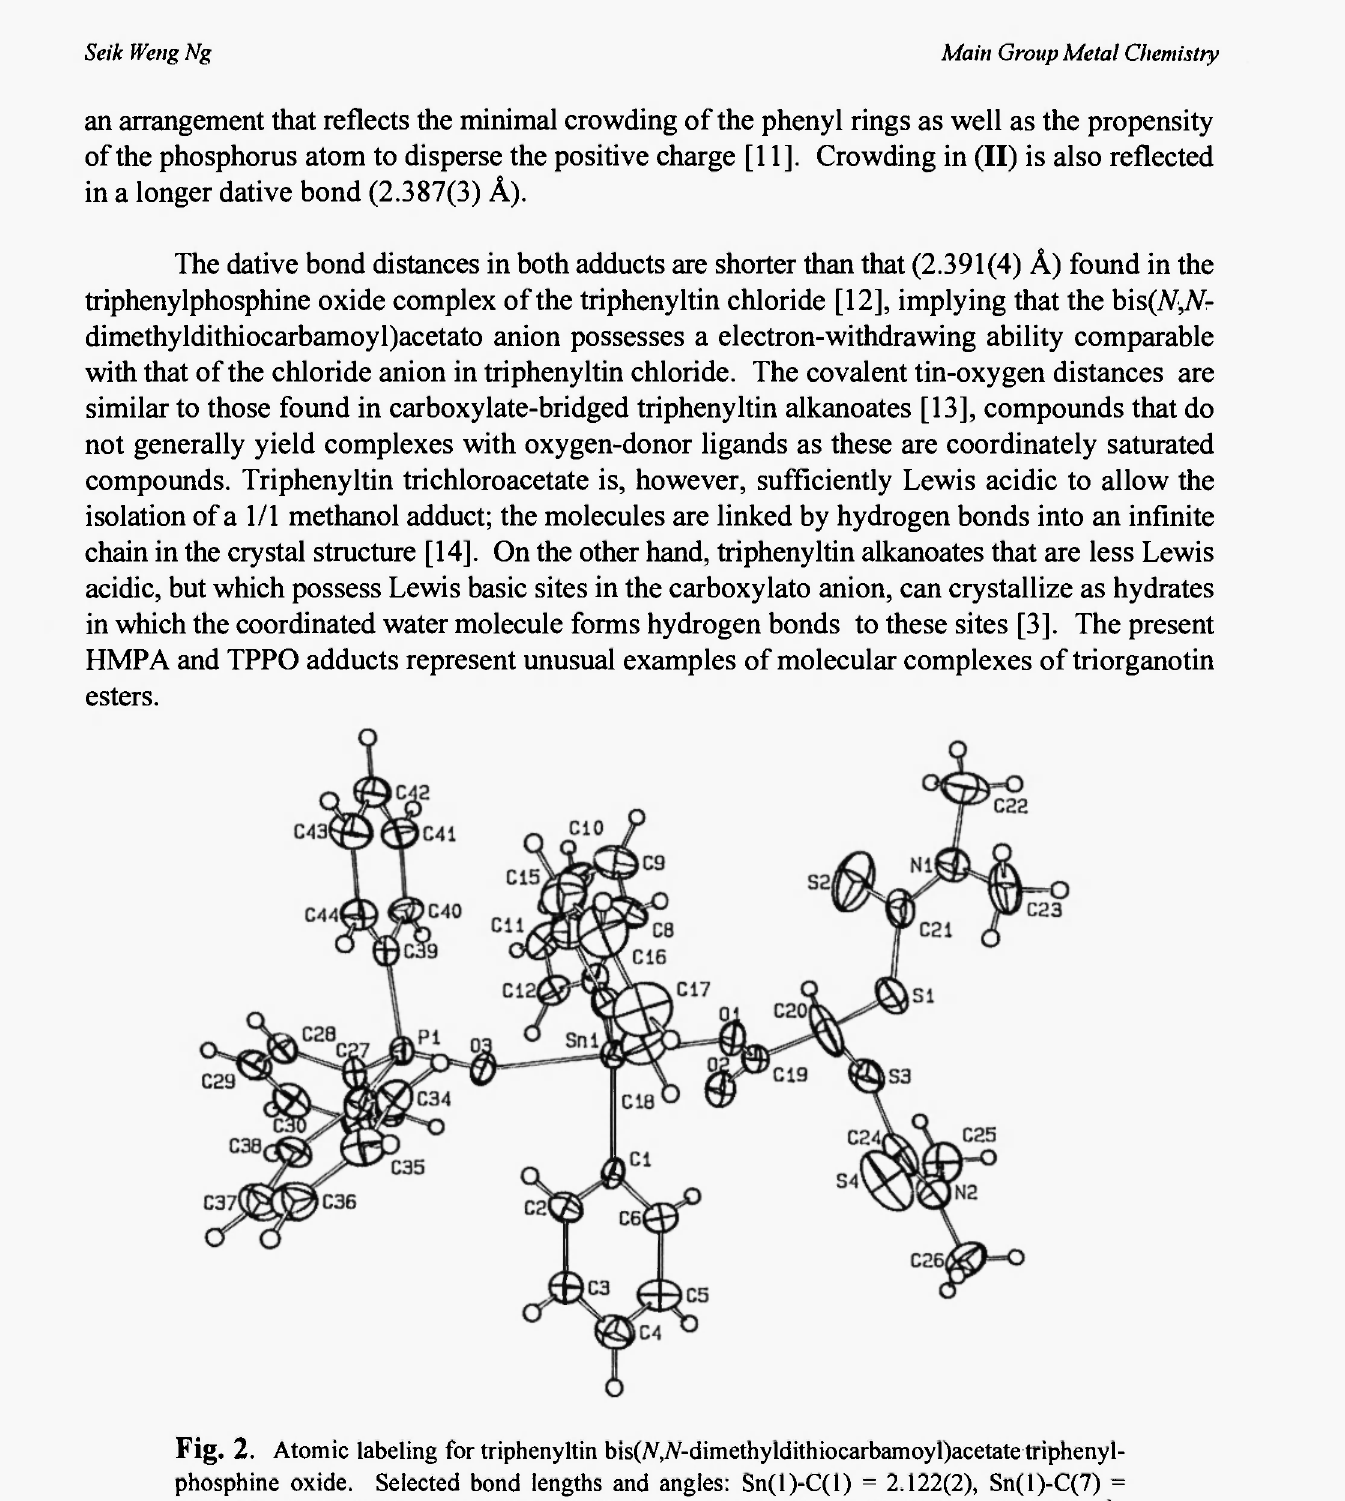
Fig. 2. Atomic labeling for triphenyltin bis(A r ,A r -dimethyldithiocarbamoyl)acetate triphenyl- phosphine oxide. Selected bond lengths and angles: Sn(l)-C(l) = 2.122(2), Sn(l)-C(7) = 2.137(3), Sn(l)-C(13) = 2.147(2), Sn(l)-0(1) = 2.161(3), Sn(l)-0(3) = 2.387(3)